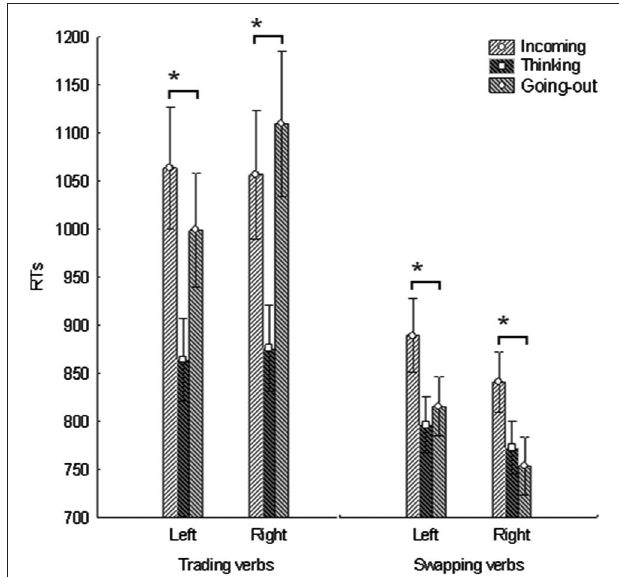
FIGURE 1 | The interplay between manual response and the comprehension of trading and swapping verbs . Reaction times for detecting the correctly spelt items of both trading and swapping categories. Vertical bars indicate one Standard Error. The “*” indicates significant post-hoc comparison